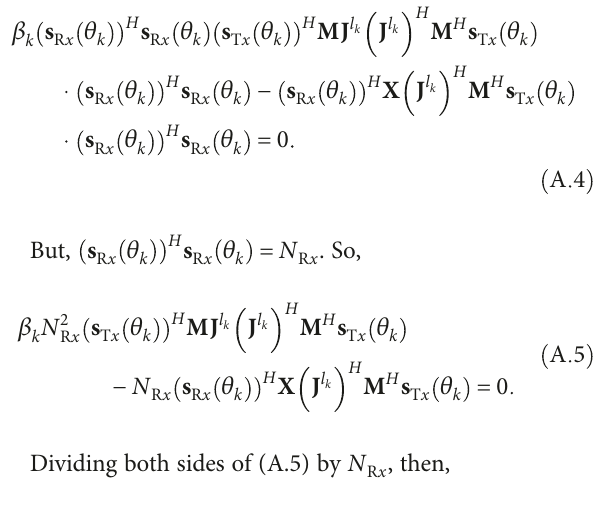
Figure 3: Root mean square error for the delay in chip time T SNR in dB for γ = 0 4